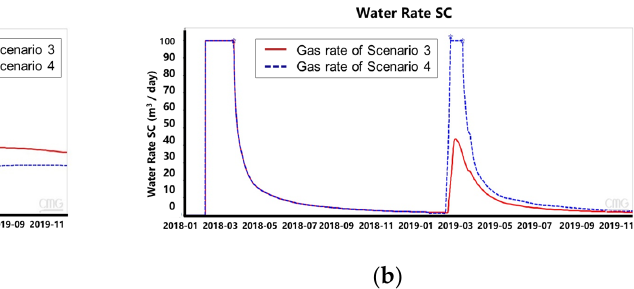
Figure 8. Comparison of gas rate and water rate of different scenarios. ( a ) Gas rate. ( b ) Water rate.